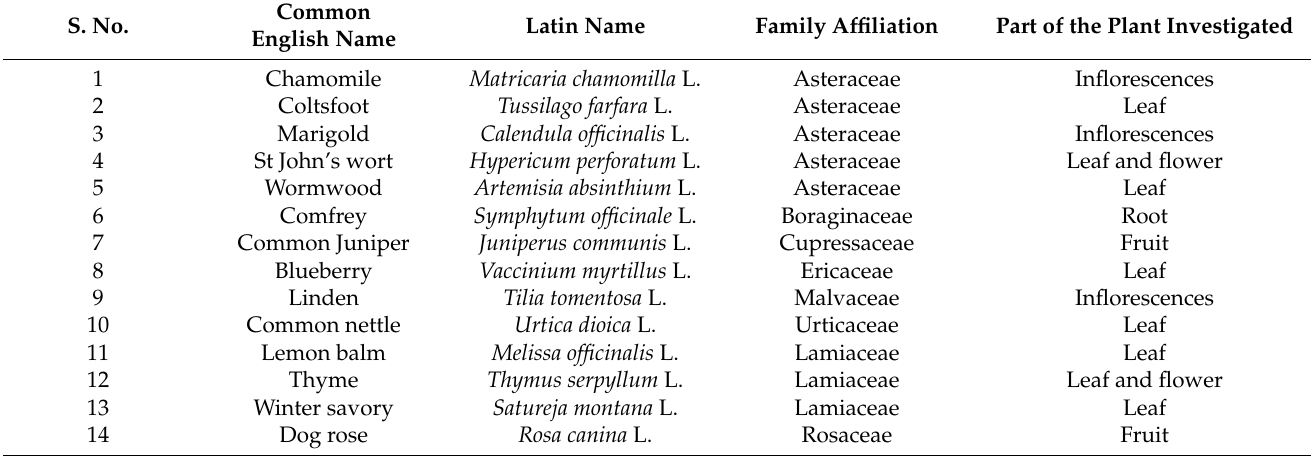
Table 1. The investigated medicinal herbs with their English and Latin name, family affiliation, and the part of the herb